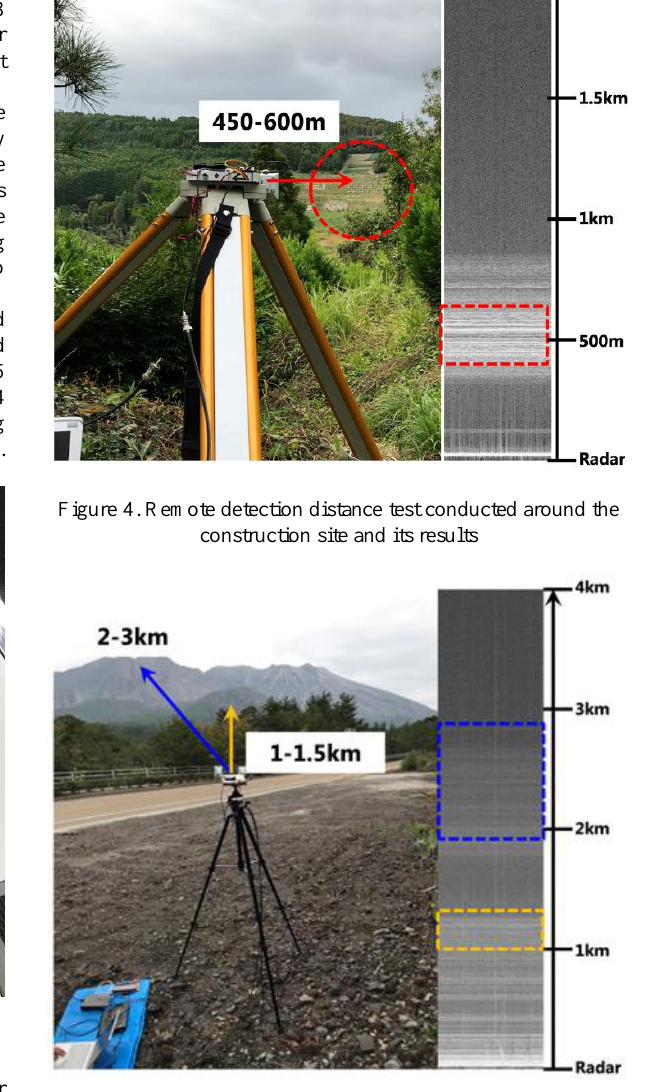
Figure 5. Remote detection distance test conducted around the active volcano and its results Next, an experiment using a corner reflector was performed to verify displacement measurement accuracy. The corner reflector installed on the stage was slid by 0.1 mm and the movement was measured by radar device. The verification test result of displacement measurement accuracy is shown in Figure 6. The black solid line means the amount of movement of the corner reflector, and the coloured graph (red, orange, blue, and green) is a record of the displacement measured by the radar. A total of 4 measurements were performed in summer and autumn, each measurement accuracy was verified to be 0.7 mm or less. Since remote sensing technique detects fluctuation of vegetation growing on the ground surface, a corner reflector was placed